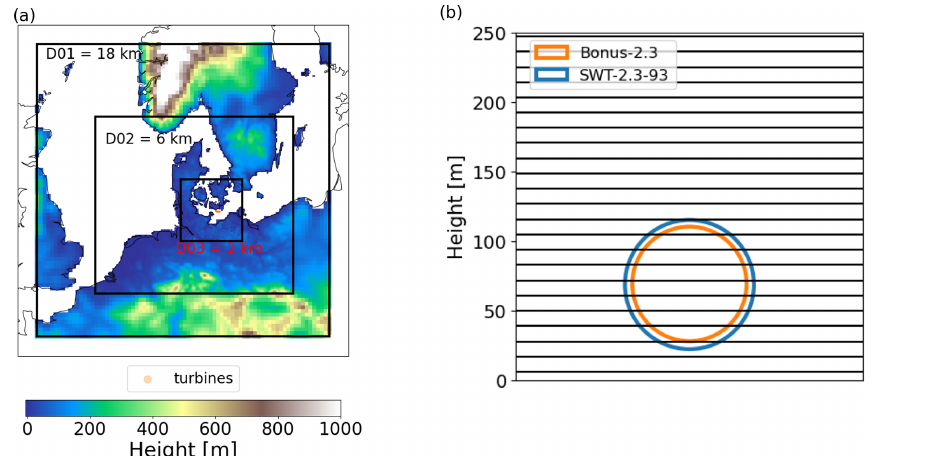
Figure 7. (a) Nested WRF domains with the innermost domain capturing the study area of the Fehmarn Belt with the Nysted and Rødsand II wind farms and (b) a vertical WRF grid with the lowest 14 mass levels and rotor areas covered by the two wind turbine